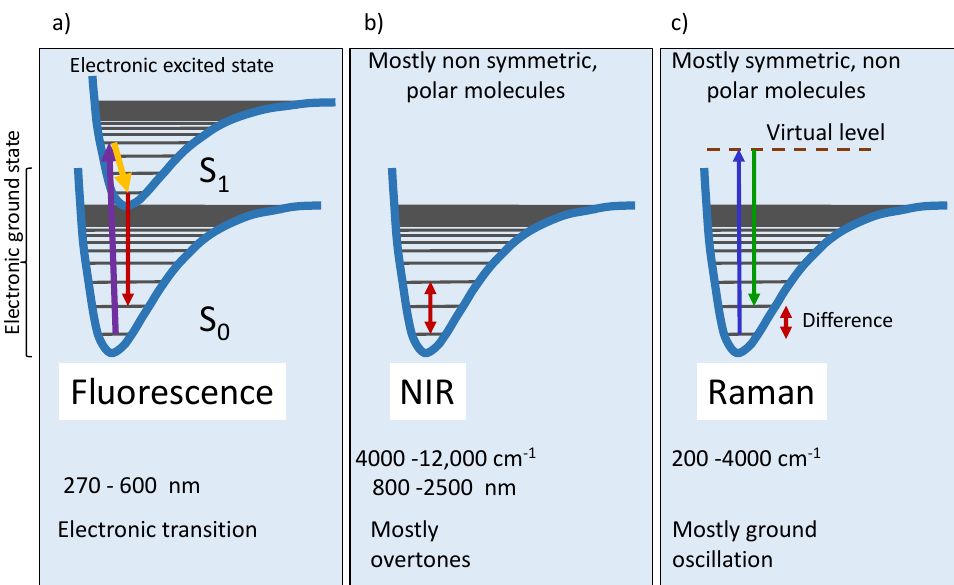
Figure 1. Simplified potential curves to illustrate different spectroscopic methods discussed here; just vibrational states are presented: ( a ) fluorescence, ( b ) NIR, ( c ) Raman. The red arrow indicates the energy involved in the corresponding radiation.